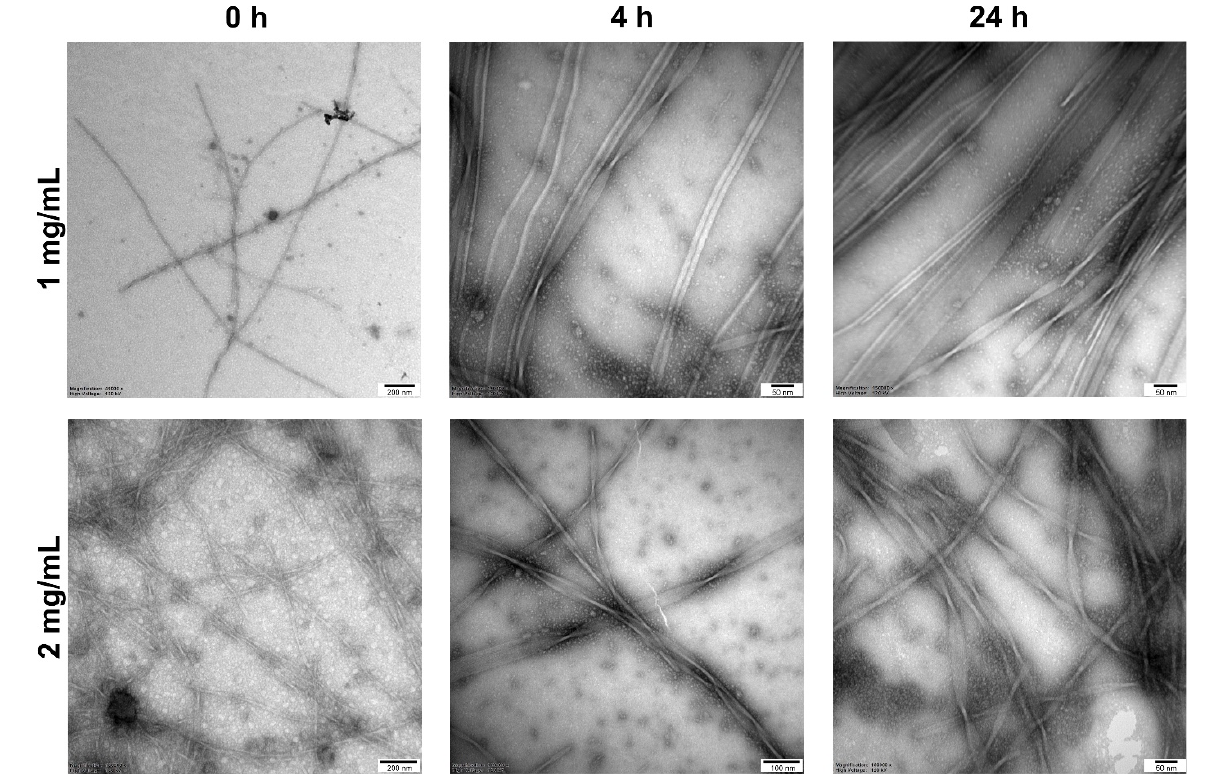
Figure 2. TEM images for the C 16 -K β AK-NH 2 samples before (after dissolution), after 4 and 24 h of incubation of the peptide at concentrations of 1 mg/mL and 2 mg/mL.